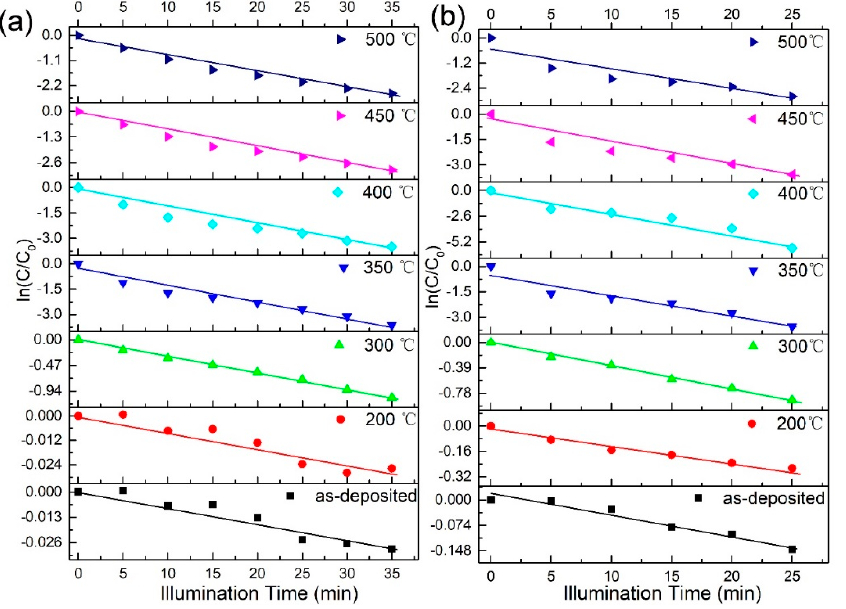
Figure 9. Kinetic plots of the photodegradation of ( a ) RhB and ( b ) MB by the photocatalysts pre- pared at different temperatures. at different temperatures.